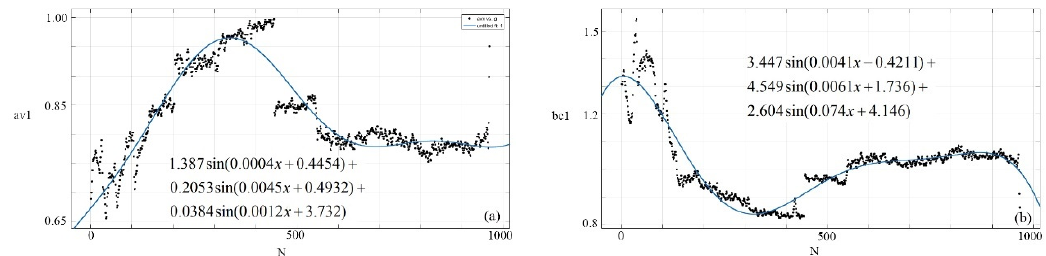
Figure 14. The model of brightness characteristic and compensation of image 1. ( a ) Model of brightness characteristic. ( b ) Model of brightness compensation.